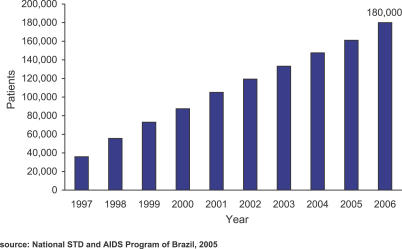
Patients Receiving HAART in Brazil, 1997–2005